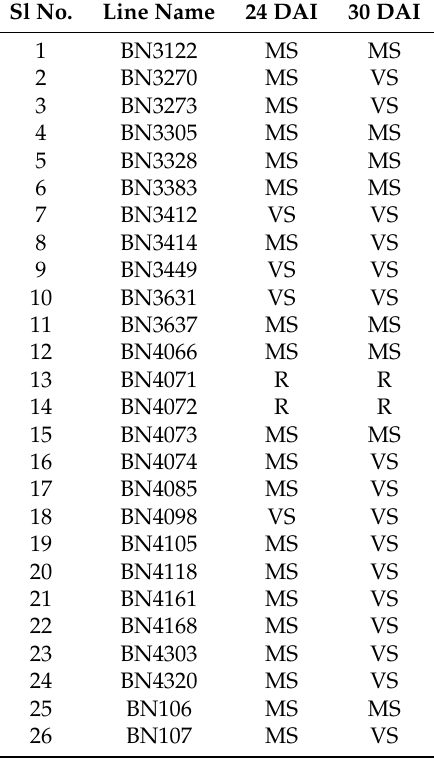
Table 1. Results of the disease assay of the 26 Brassica oleracea lines to evaluate the levels of resistance in cabbage to ringspot based on the following grading criteria: 1 = 0%, 2 = 1–5%, 3 = 6–20%, 4 = 21–50%, and 5 = greater than 50% infected leaf surface. Plant lines rated 1–2 are considered resistant (R), those rated 3 are considered moderately resistant (MR), lines rated 4 are considered moderately susceptible (MS), and those rated 5 are considered very susceptible (VS). DAI: Days after inoculation. Sl